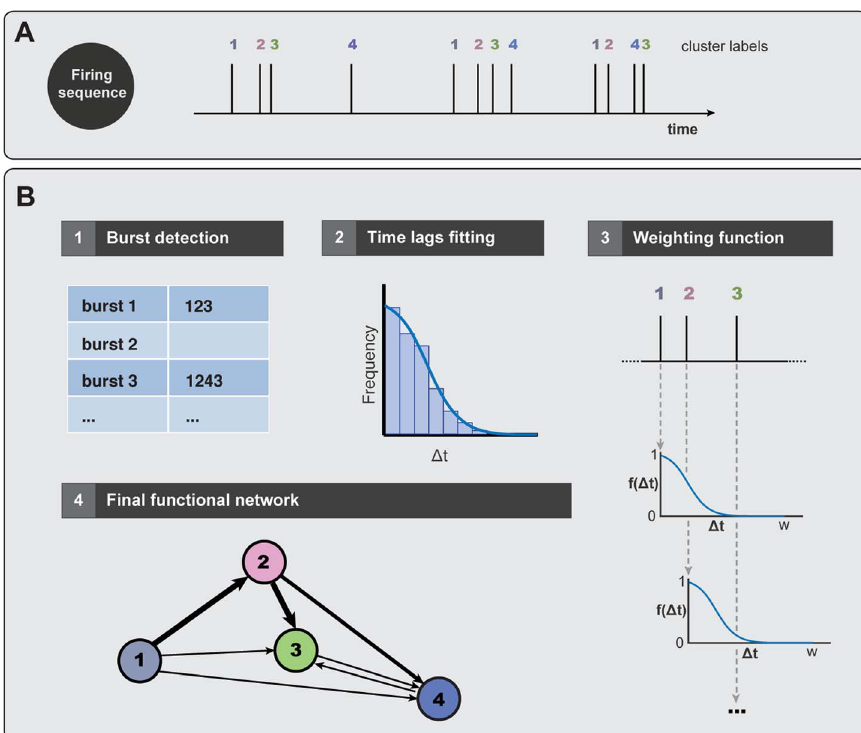
Figure 2. Sketch of the construction of the directed functional network. A Schematic representation of the experimental data, with 12 firings of four different clusters (or neurons in the case of homogeneous cultures). B Stages of the method to construct the directed functional network. (1) The first step consists in detecting the different bursts in the whole sequence. Firings that are separated by more than 200ms for clustered cultures ( 10ms for homogeneous ones) are not considered part of the same burst. (2) Calculation of the time lags D t between consecutive firings inside the bursts, for the whole sequence. The frequency distribution of time lags is next fitted to a Gaussian distribution f( D t ) * exp( { ( D t ) 2 = c ) , finally providing the variance c that will be specific for each culture. (3) Weighting procedure example for the first burst. Cluster # 1 can activate # 2 and # 3. The weight of the links 1 ? 2 and 1 ? 3 depends on the time differences between clusters’ activations, and is given by the function f( D t ) determined by the previous fitting. Hence, weight (cid:2) w 1 ? 2 ^ 0 : 6 , and (cid:2) w 1 ? 3 ^ 0 . Cluster # 3 can be activated as well by cluster # 2, with (cid:2) w 2 ? 3 ^ 0 : 2 . (4) Schematic representation of the resulting directed functional connectivity network. The width of the connections is proportional to the weight of the links for clarity.